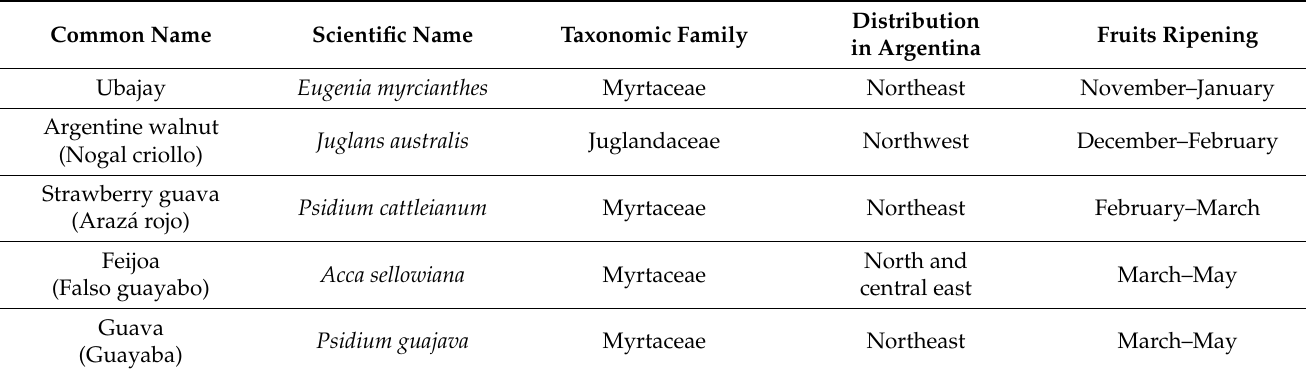
Table 1. Native host fruits included in the